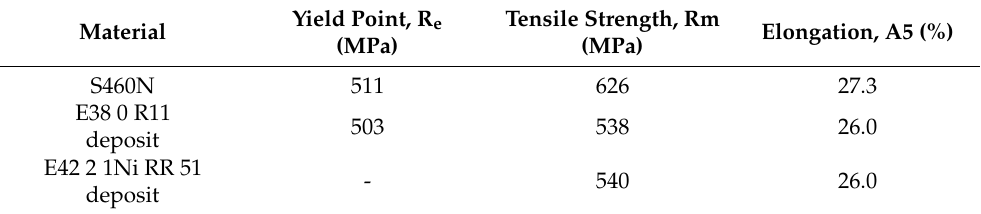
Table 2. The mechanical properties of the used materials following the manufacturers’ data.